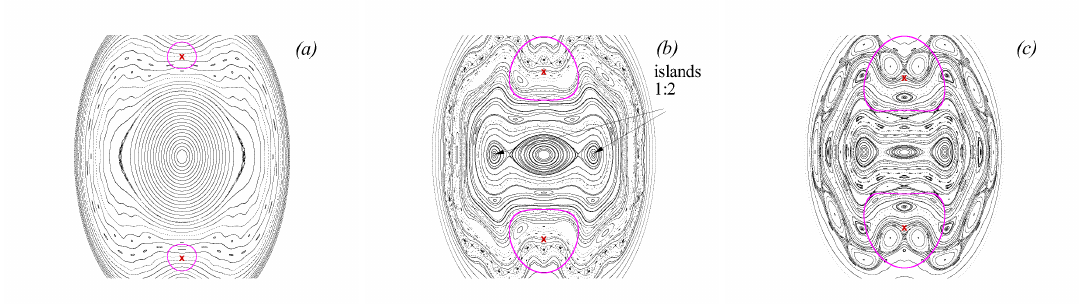
Figure 26. Poincaré maps for the upper-layer advection system perturbed by two lower-layer vortices of equal weak strength µ = 0.03 when S 0 = − 0.01, Ω 0 = − 0.02 and the shift of the vortices from their stationary positions is: ( a ) 0.1; ( b ) 0.3; and ( c )